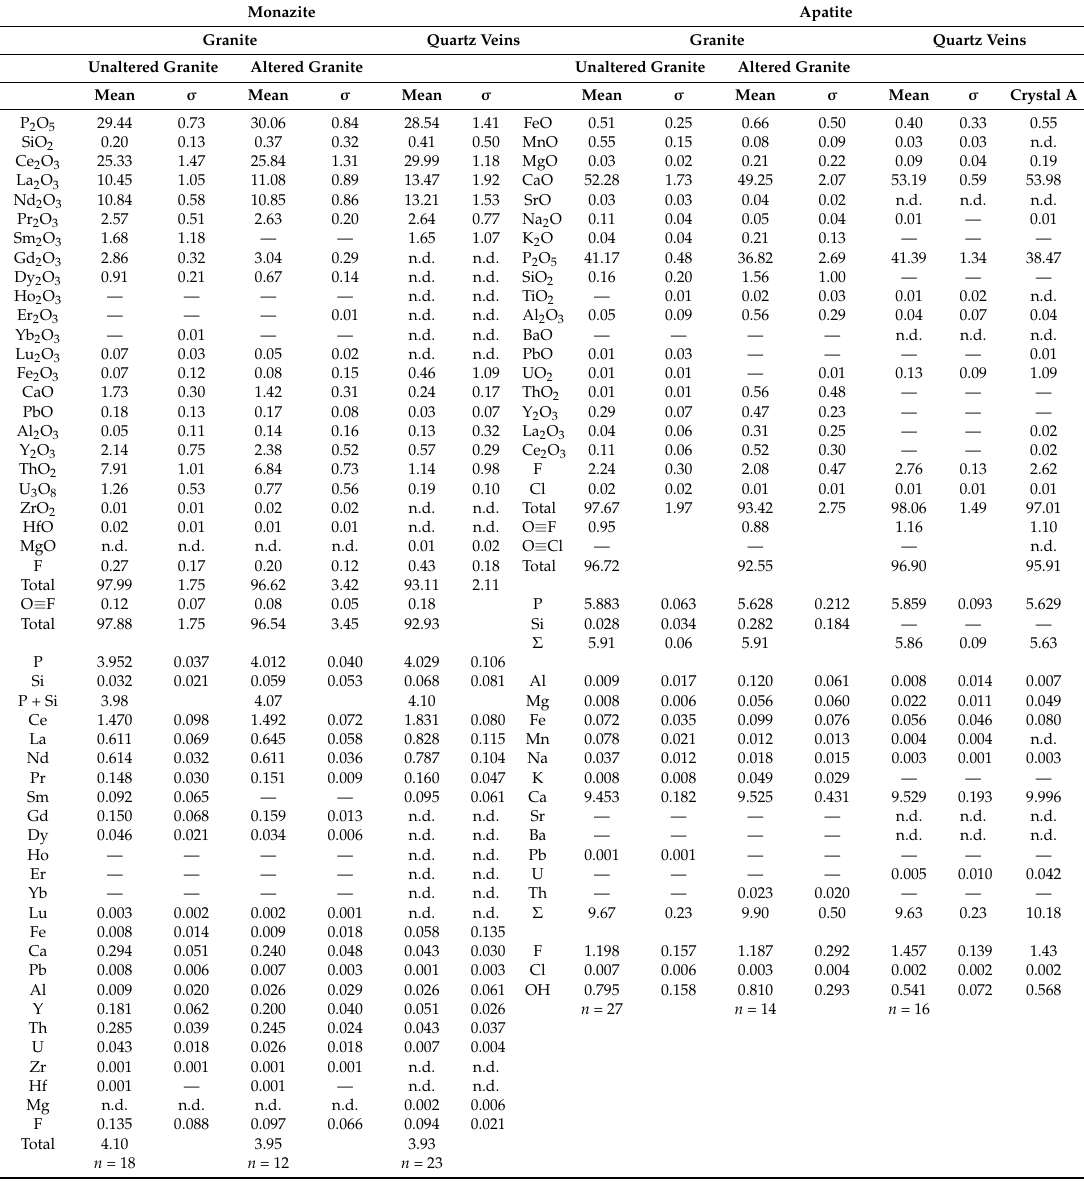
Table 3. Chemical composition (in weight percent) and structural formula of monazite and apatite from the Variscan unaltered and altered granites, and associated hydrothermal quartz veins, Central